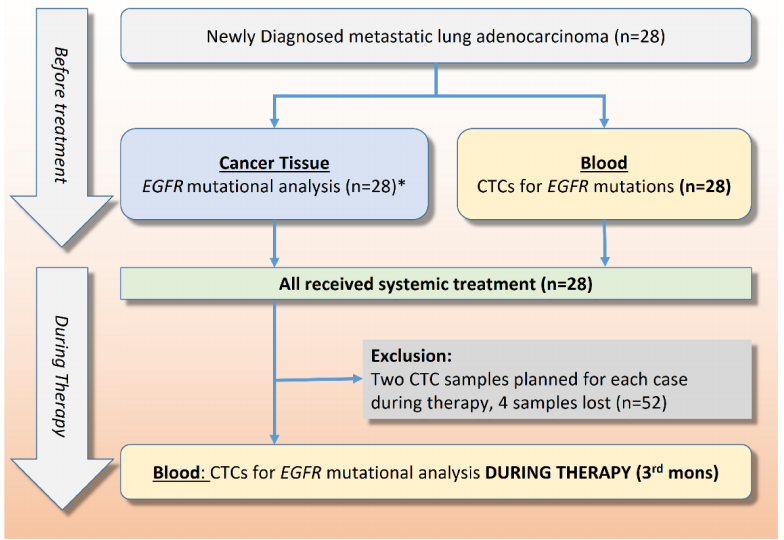
Figure 1. Study flow (Abbreviations: EGFR, epidermal growth factor receptor; CTC, circulating tumor cells; PS-CTC, positively selected circulating tumor cells; WGA, whole-genome amplification; ARMS, amplification refractory mutation system, Seq., sequencing). * The results of cancer tissue EGFR mutational analysis were EGFR mutant (n = 17) and EGFR non-mutant type (n = 11), which were unknown before CTC isolation.